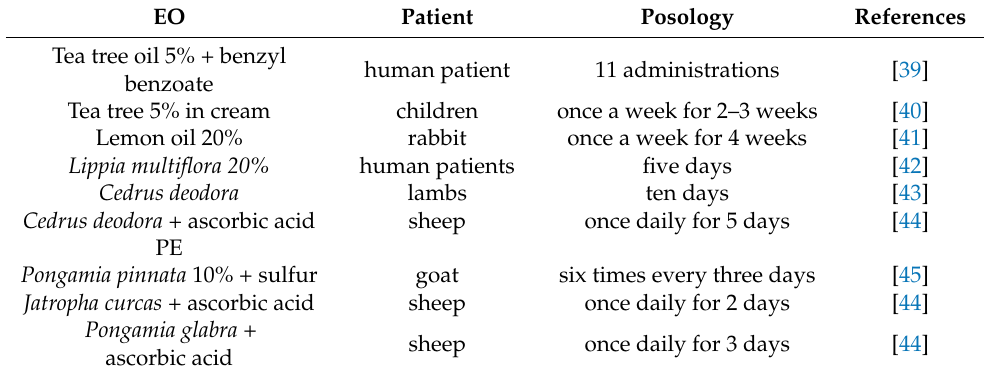
Table 2. In vivo successful administration of essential oils (EOs) and plant extracts